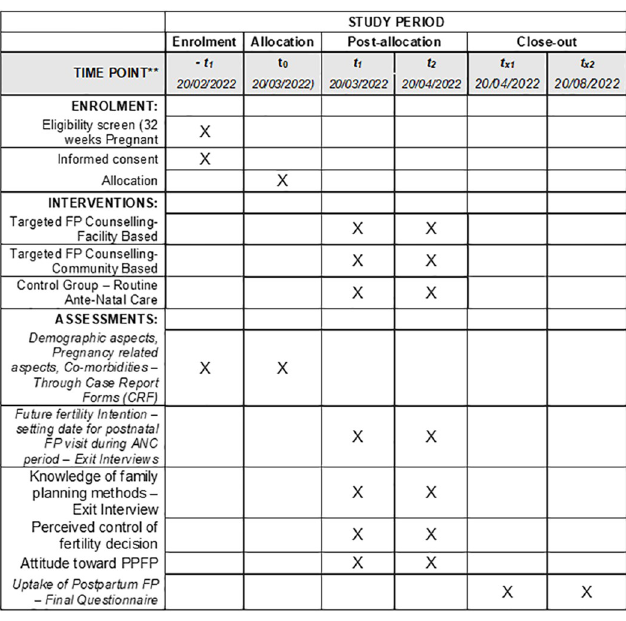
Fig 1. SPIRIT schedule for enrolment, allocation, post-allocation and close-out.